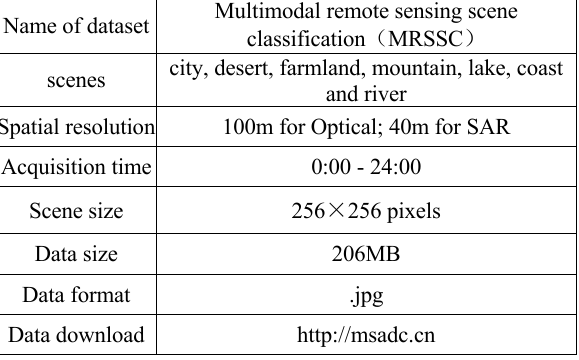
Table 3 . Multimodal remote sensing scene classification Compared with the existing multi-modal remote sensing scene